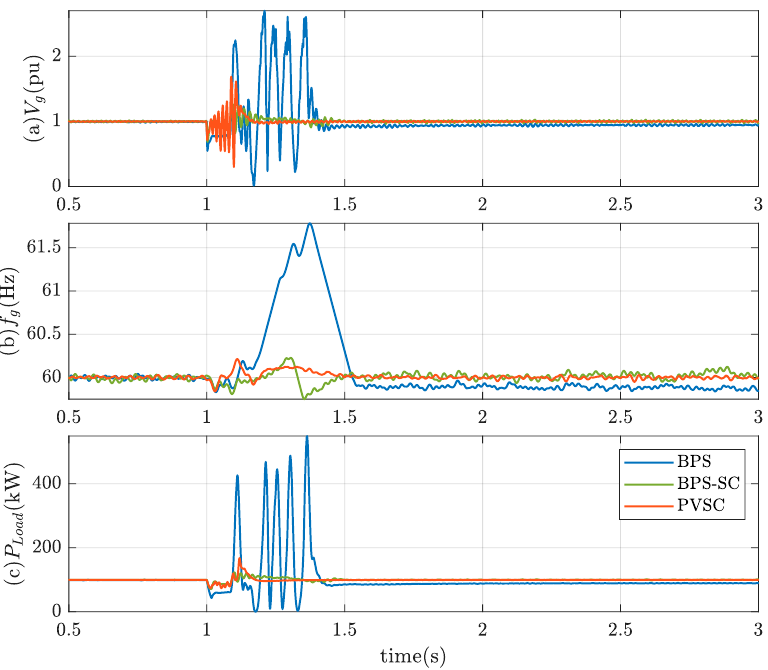
Figure 28. Fault analysis evaluation: ( a ) and ( b ) grid voltage and frequency at load point, and ( c ) load power.